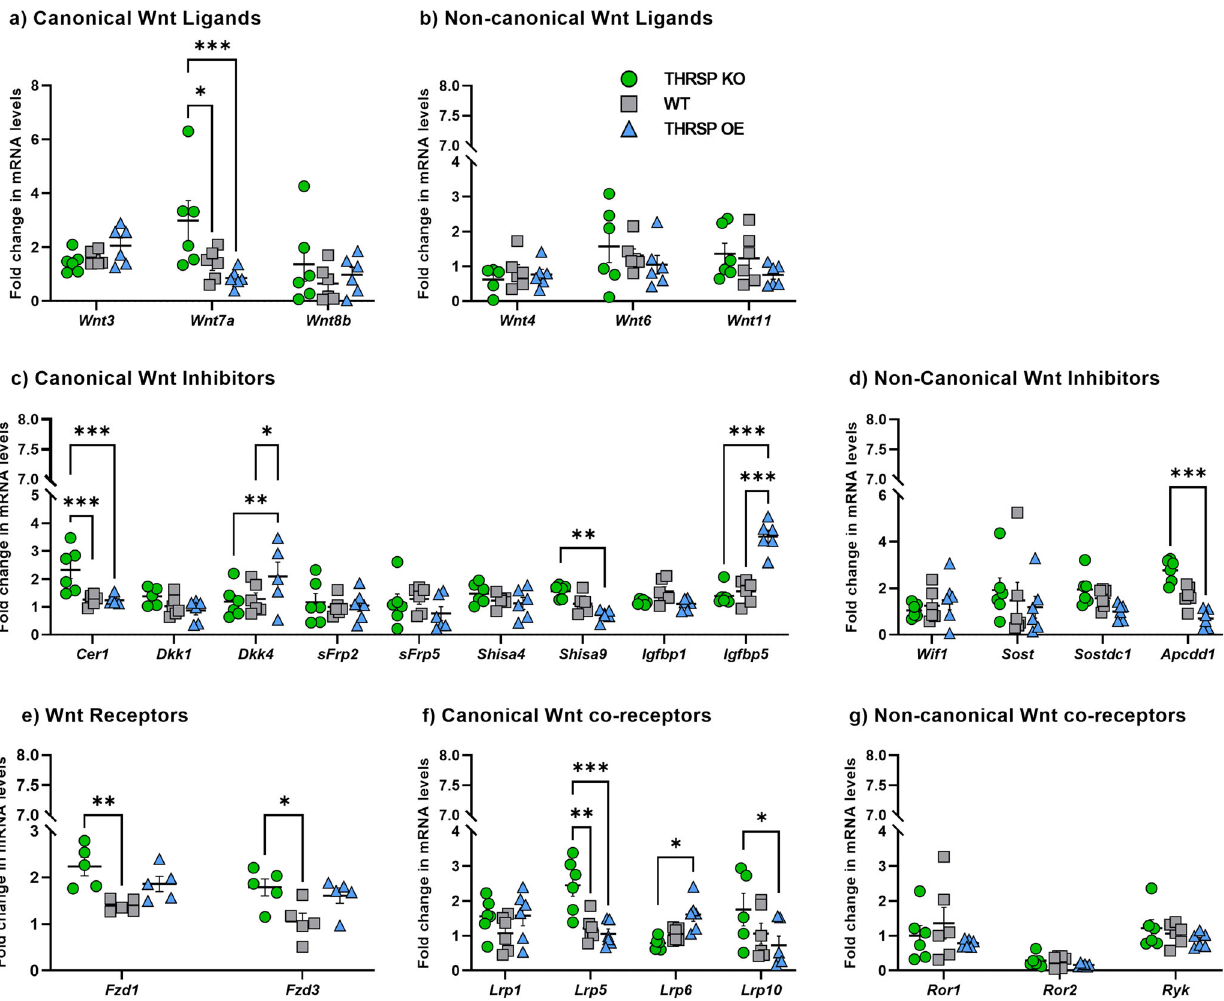
Fig. 4 Canonical and noncanonical Wnt pathway elements expressions in the mouse hippocampal DG. qRT-PCR analyses of a canonical and b noncanonical Wnt ligands ( n = 6 mice/group; a two-way ANOVA, Strain: F ( 2, 45 ) = 3.24, P = 0.048; Gene targets: F (2, 45) = 3.58, P = 0.036; Strain × Gene targets: F ( 4, 45 ) = 3.41, P = 0.016; b two-way ANOVA, Strain: F ( 2, 44 ) = 1.35, P = 0.269; Gene targets: F ( 2, 44 ) = 3.53, P = 0.038; Strain × Gene targets: F ( 4, 44 ) = 0.626, P = 0.647). The mRNA expression levels of c canonical and d noncanonical Wnt inhibitors ( n = 6 mice/group; c two-way ANOVA, Strain: F ( 2, 133 ) = 1.70, P = 0.186; Gene targets: F ( 8, 133 ) = 9.61, P < 0.001; Strain × Gene targets: F ( 16, 133 ) = 7.31, P < 0.001; d two- way ANOVA, Strain: F ( 2, 60 ) = 5.16, P = 0.009; Gene targets: F ( 3, 60 ) = 0.754, P = 0.524; Strain × Gene targets: F ( 6, 60 ) = 1.99, P = 0.081). mRNA levels of e Wnt receptors, f canonical Wnt co-receptors, and g noncanonical Wnt co-receptors. e Two-way ANOVA, Strain: F ( 2, 24 ) = 11.18, P < 0.001; Gene targets: F ( 1, 24 ) = 6.67, P = 0.0.16; Strain × Gene targets: F ( 2, 24 ) = 0.182, P = 0.835; f two-way ANOVA, Strain: F ( 2, 59 ) = 5.33, P = 0.007; Gene targets: F ( 3, 59 ) = 2.10, P = 0.110; Strain × Gene targets: F ( 6, 59 ) = 4.76, P < 0.001; g two-way ANOVA, Strain: F ( 2, 45 ) = 1.64, P = 0.205; Gene targets: F ( 2, 45 )